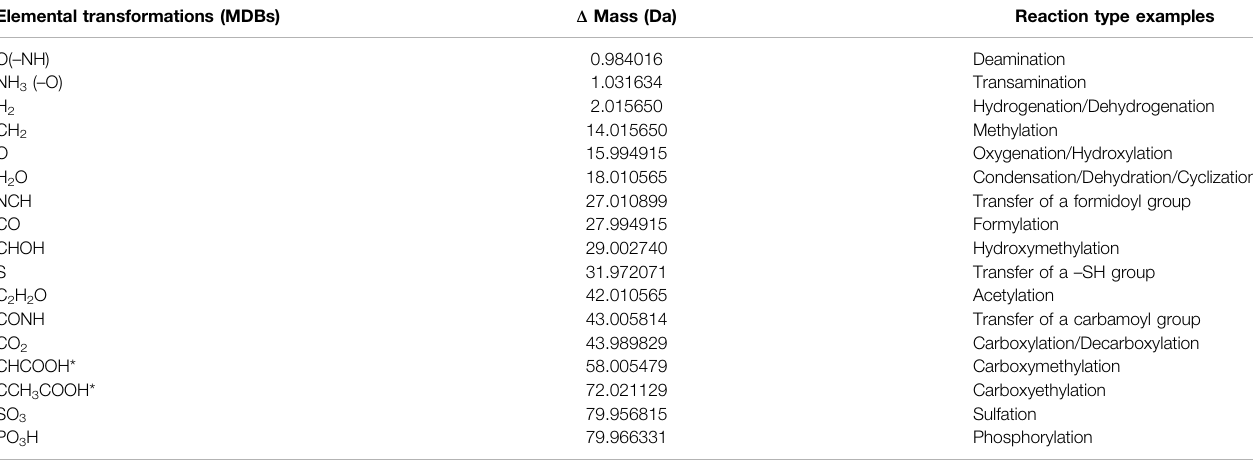
TABLE 2 | List of MDBs used to build the